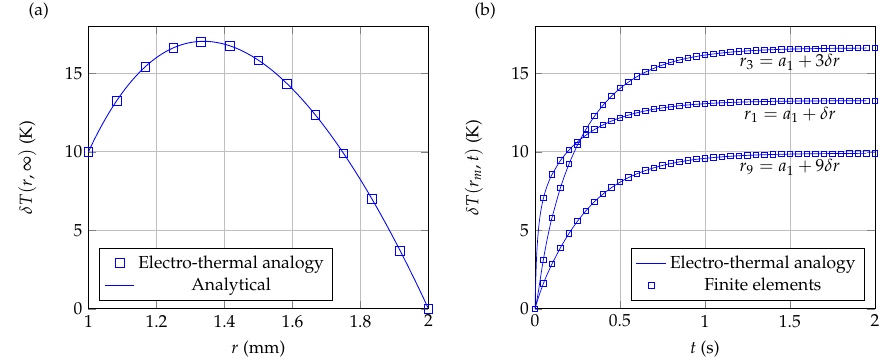
Figure 8. Electro-thermal modeling of a shell subjected to Dirichlet boundary conditions, with a con- stant heat volumetric source. ( a ) Steady state temperature profile through the shell. ( b ) Temperature variations as a function of time at different points throughout the